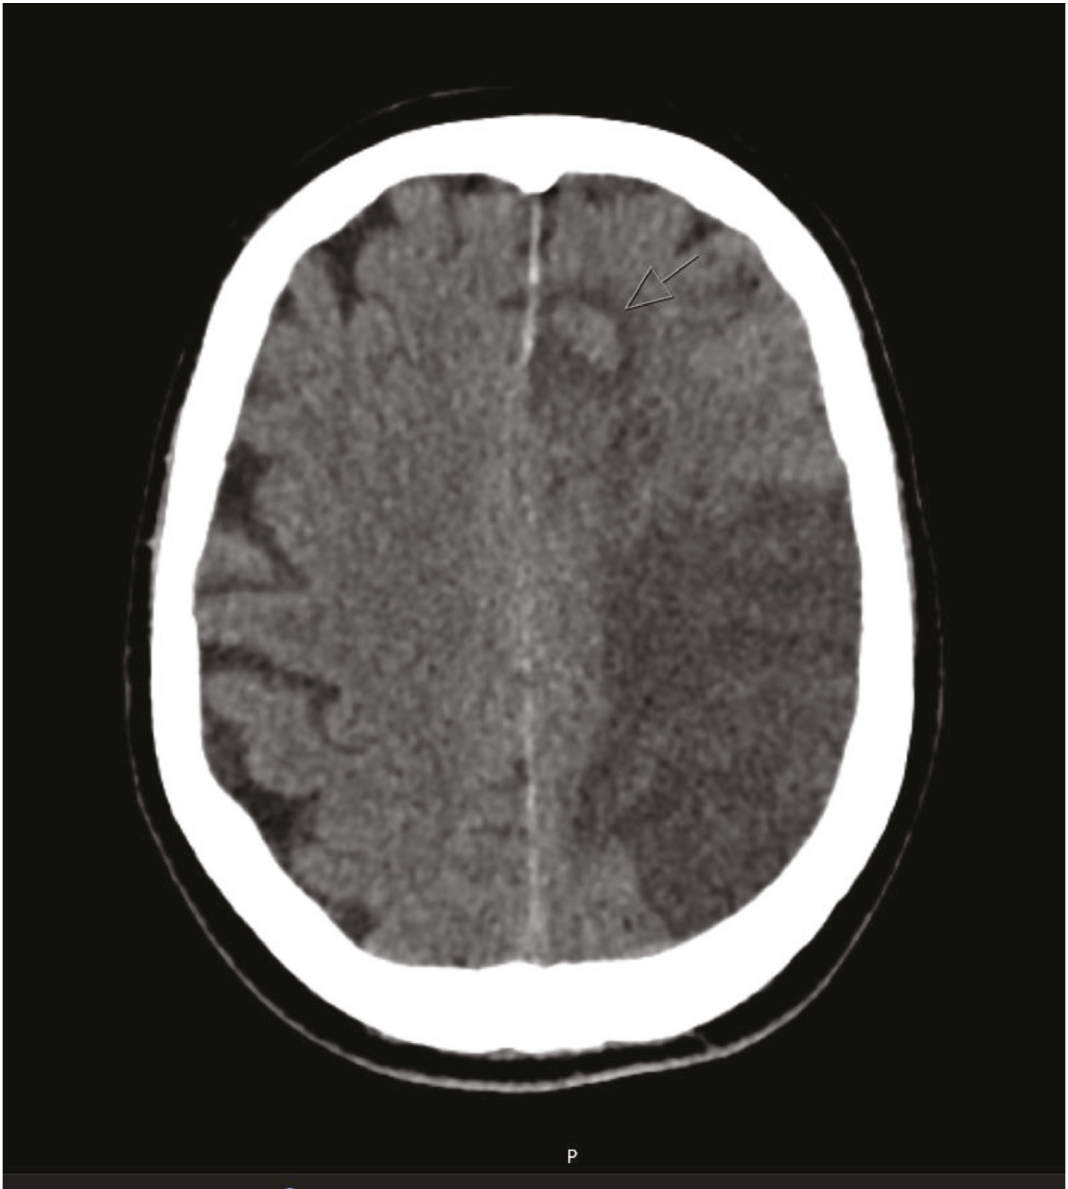
Figure 3: Noncontrast CT brain performed on day 3, revealing haemorrhage in the ACA